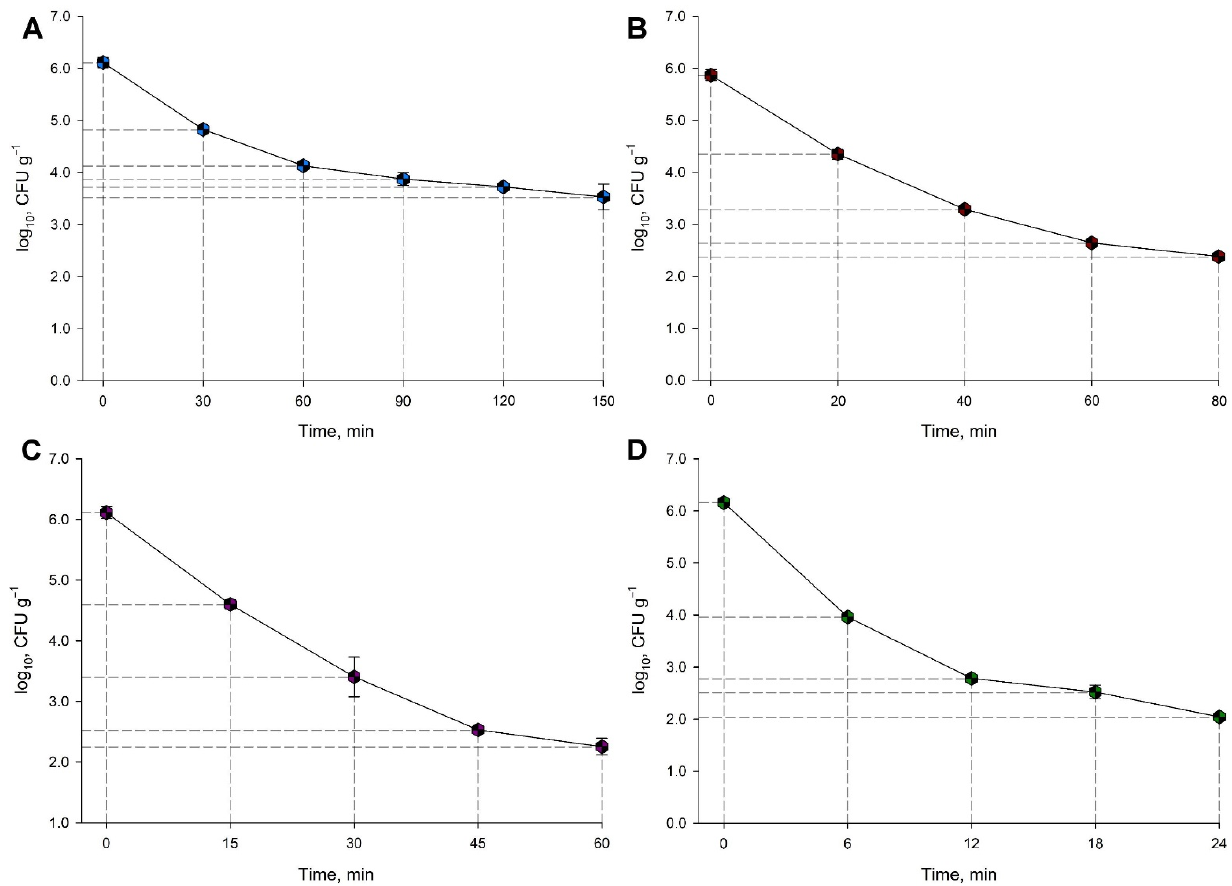
Figure 5. Thermal destruction curves of Salmonella spp. after inoculated feed was treated at 65 °C ( A ), 70 °C ( B ), 75 °C ( C ), and 80 °C ( D ).